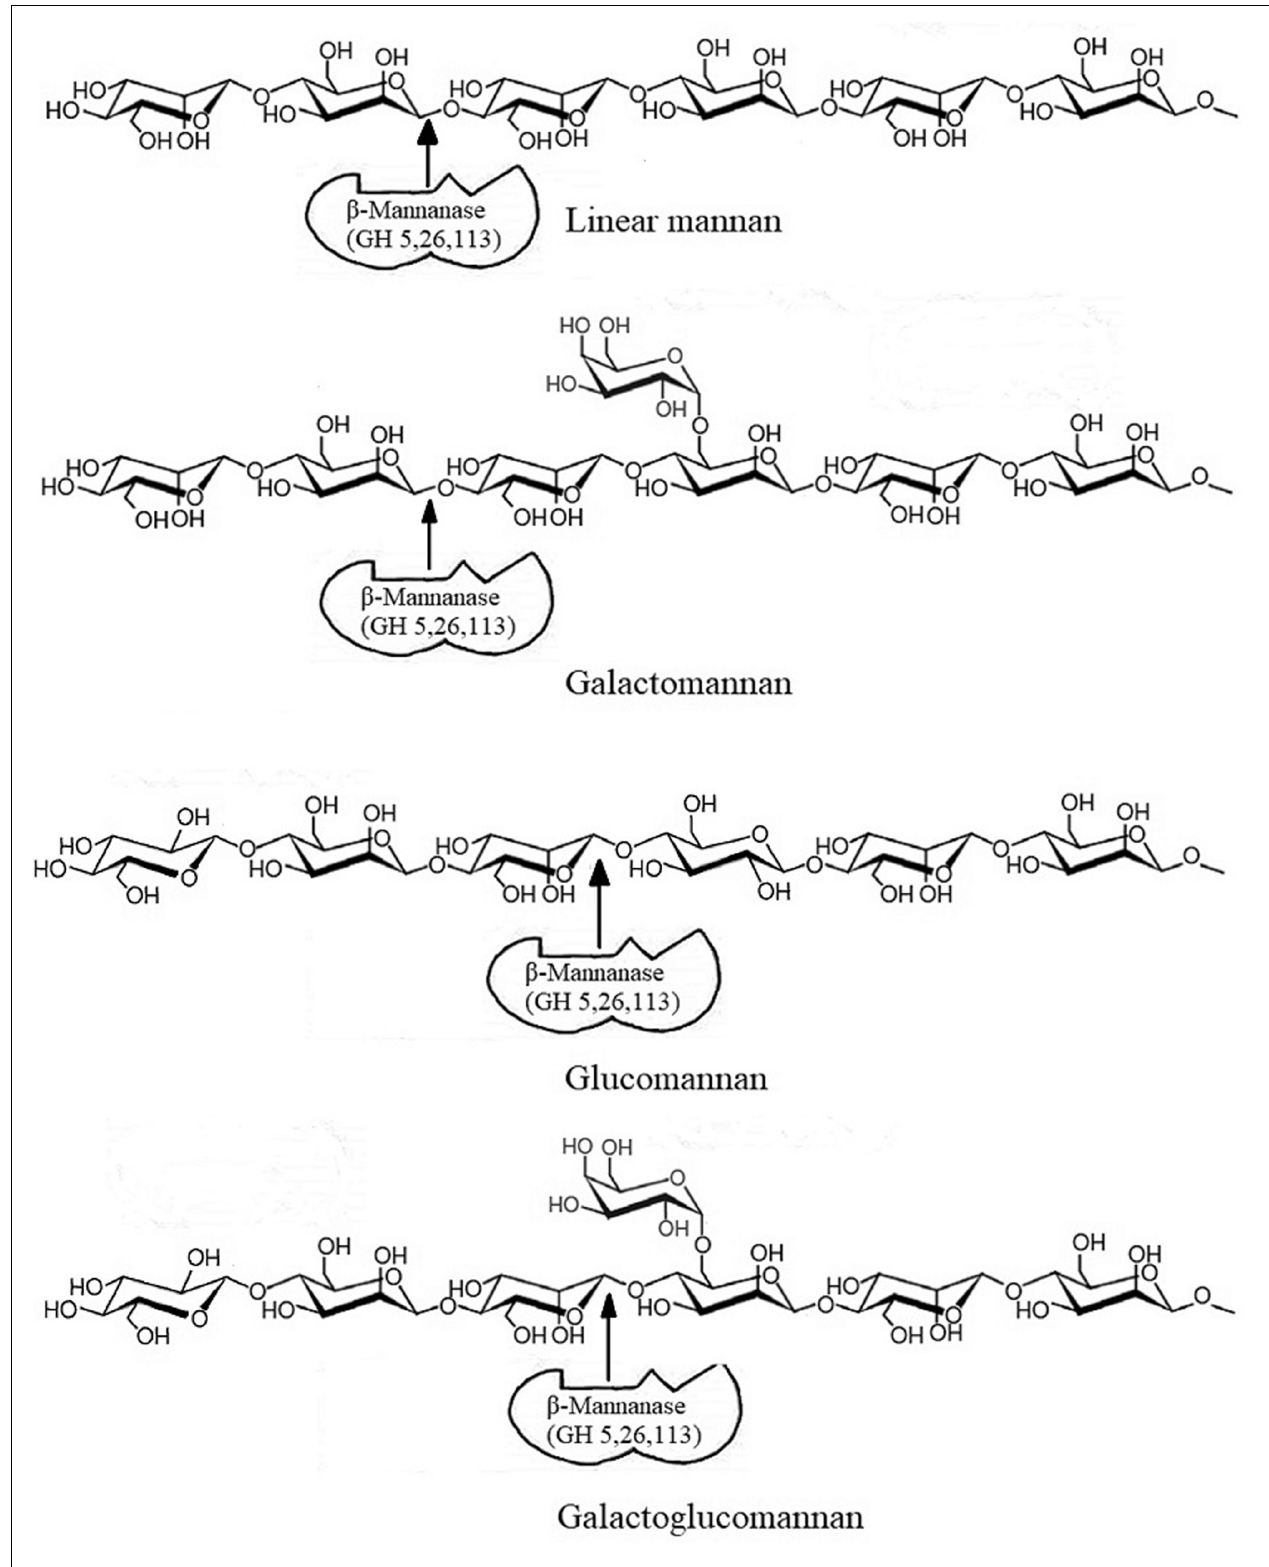
FIGURE 1 | Action of β -mannanase on different types of mannan. Modified from Yeoman et al. (2010).